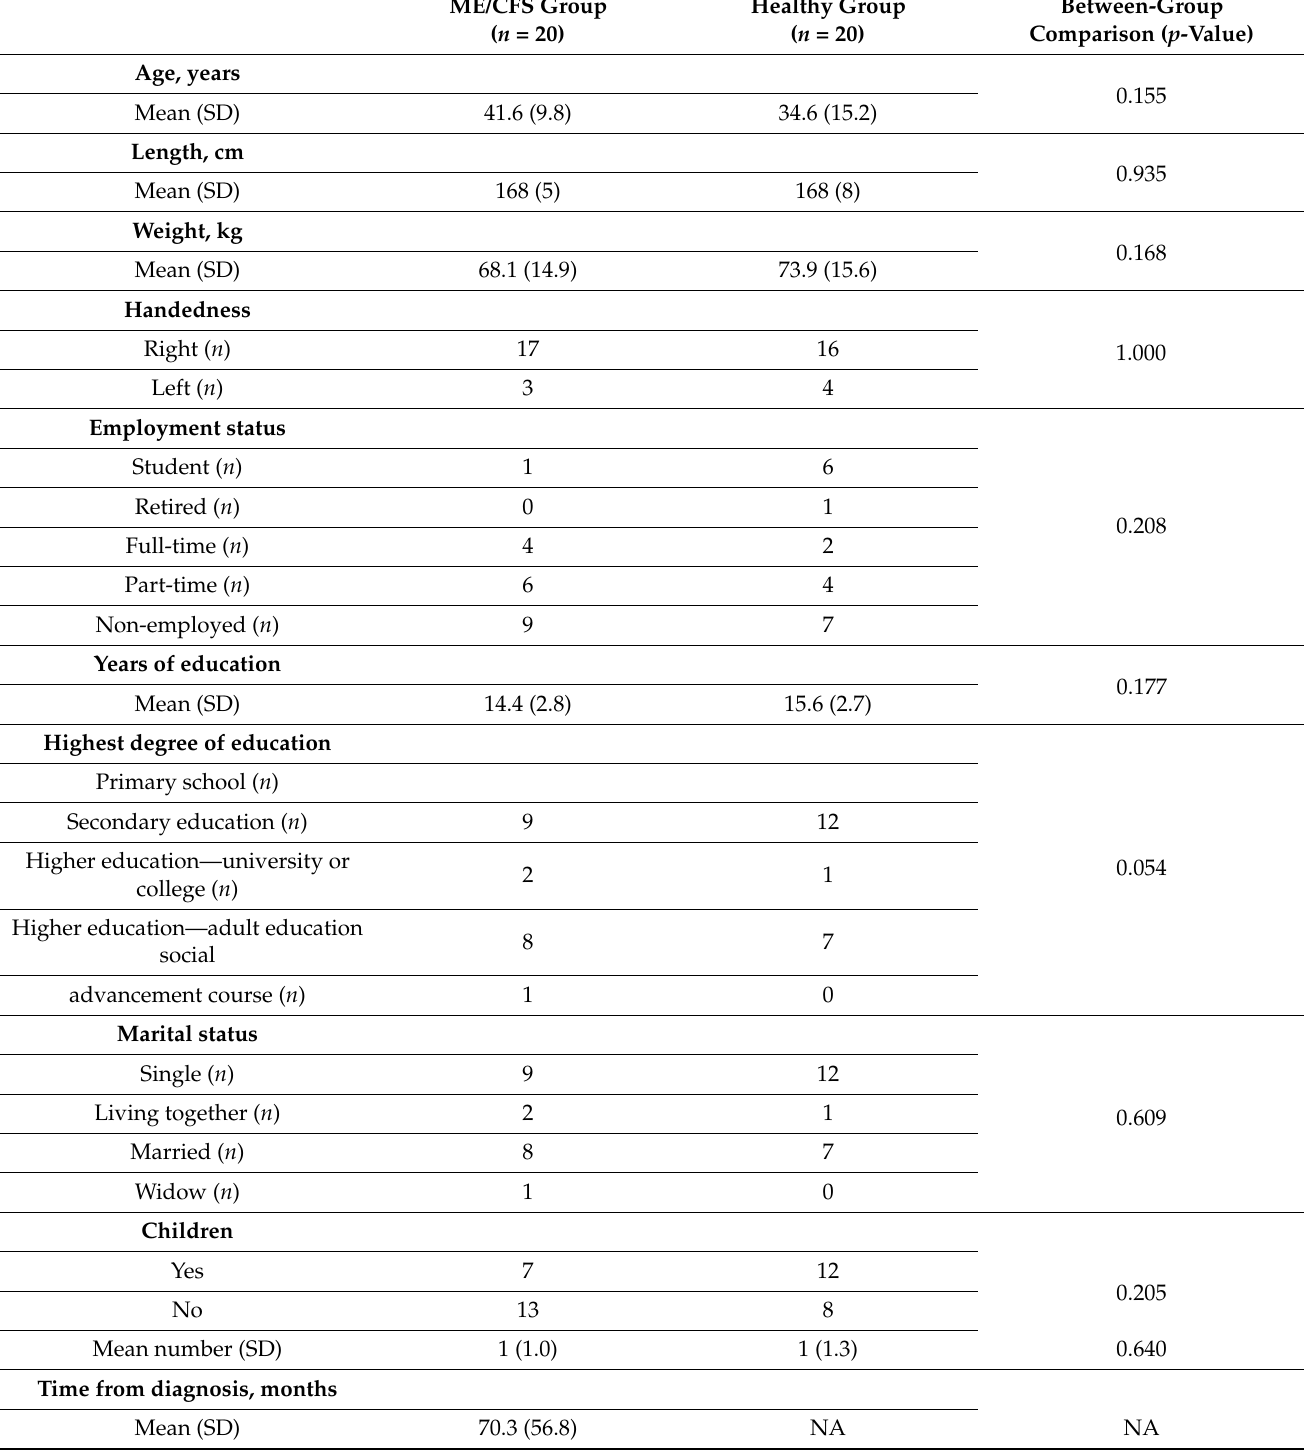
Abbreviations: SD: standard deviation, n: number of, NA: not